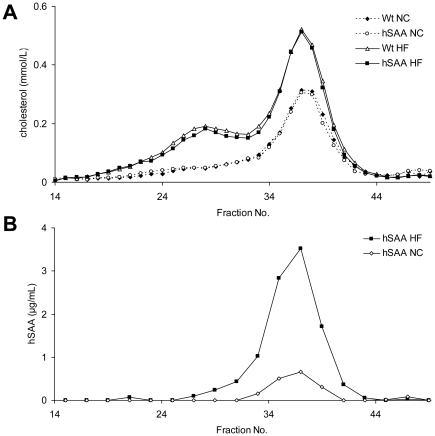
Distribution of cholesterol and hSAA in lipoproteins.Pooled plasma samples from transgenic (hSAA) and wild type (Wt) male animals fed either NC or HF diet (n = 7–10 per group) were subjected to FPLC as detailed in “Methods”. (A) Cholesterol levels in plasma FPLC fractions from Wt and hSAA animals. (B) hSAA levels in plasma FPLC fractions from hSAA animals.